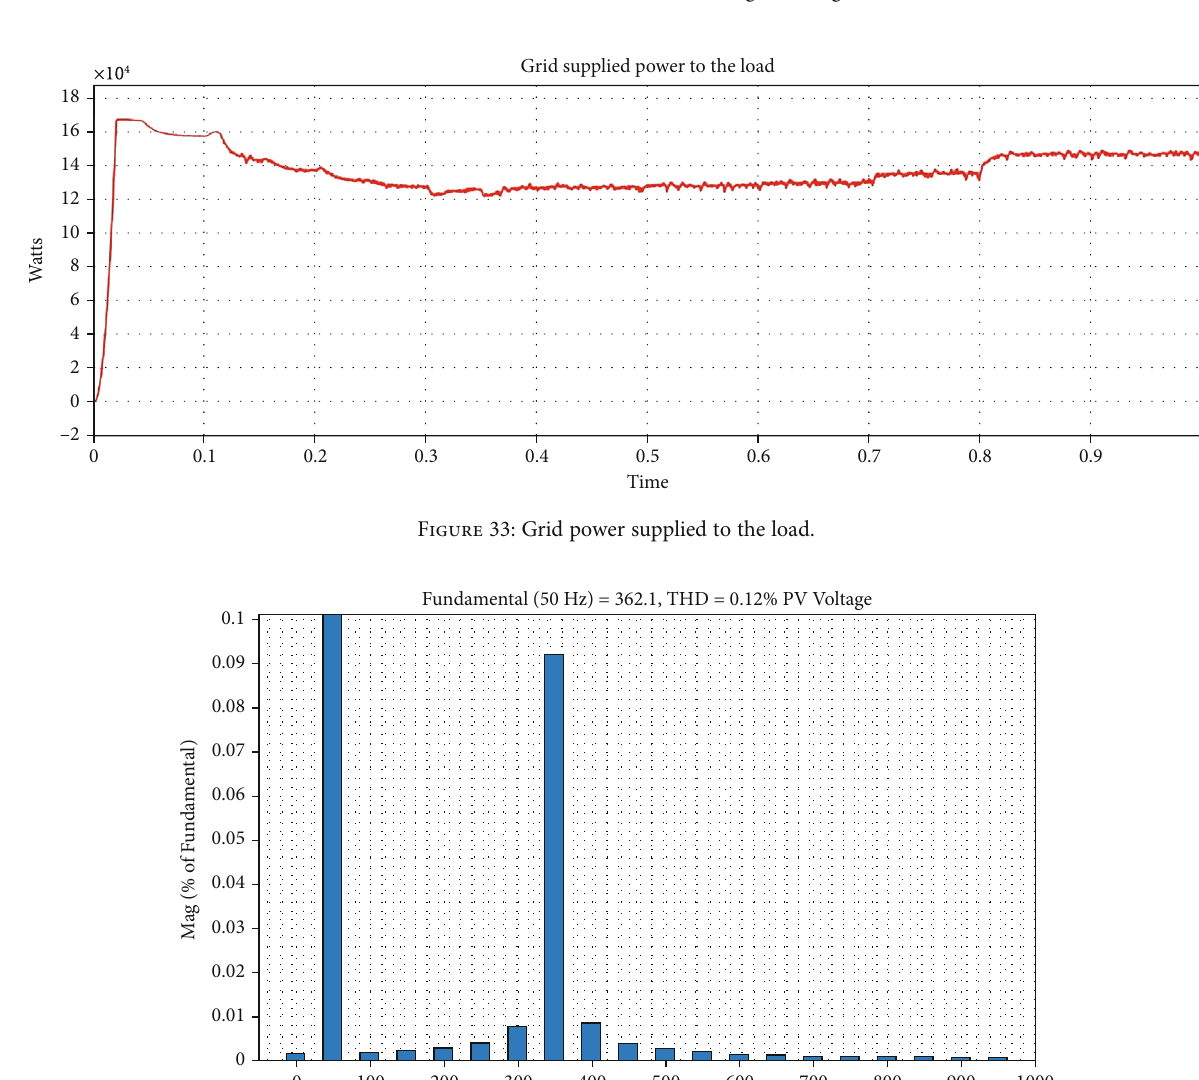
Figure 32: Current waveform and microgrid voltage.